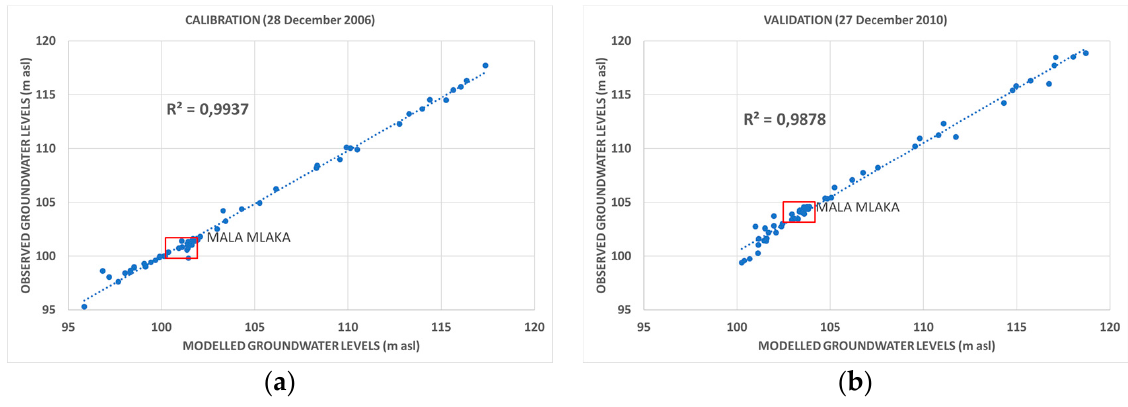
Figure 8. Calibration ( a ) and validation ( b ) of the model.